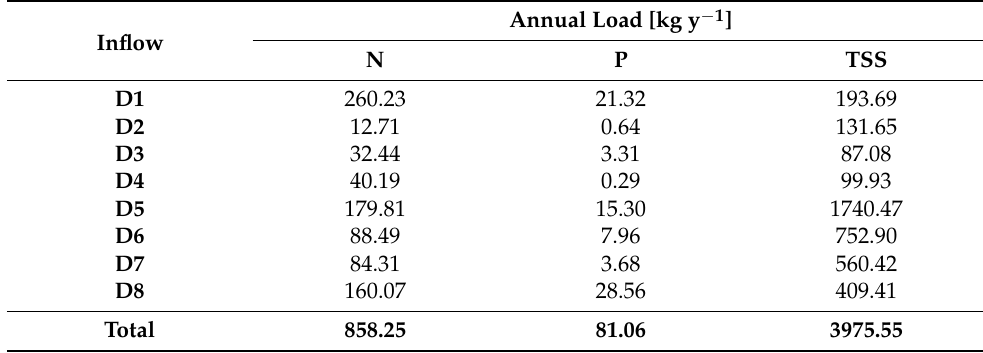
Table 5. Corrected annual loads of nitrogen (N), phosphorus (P), and total suspended solids (TSS) entering the lake for average conditions.